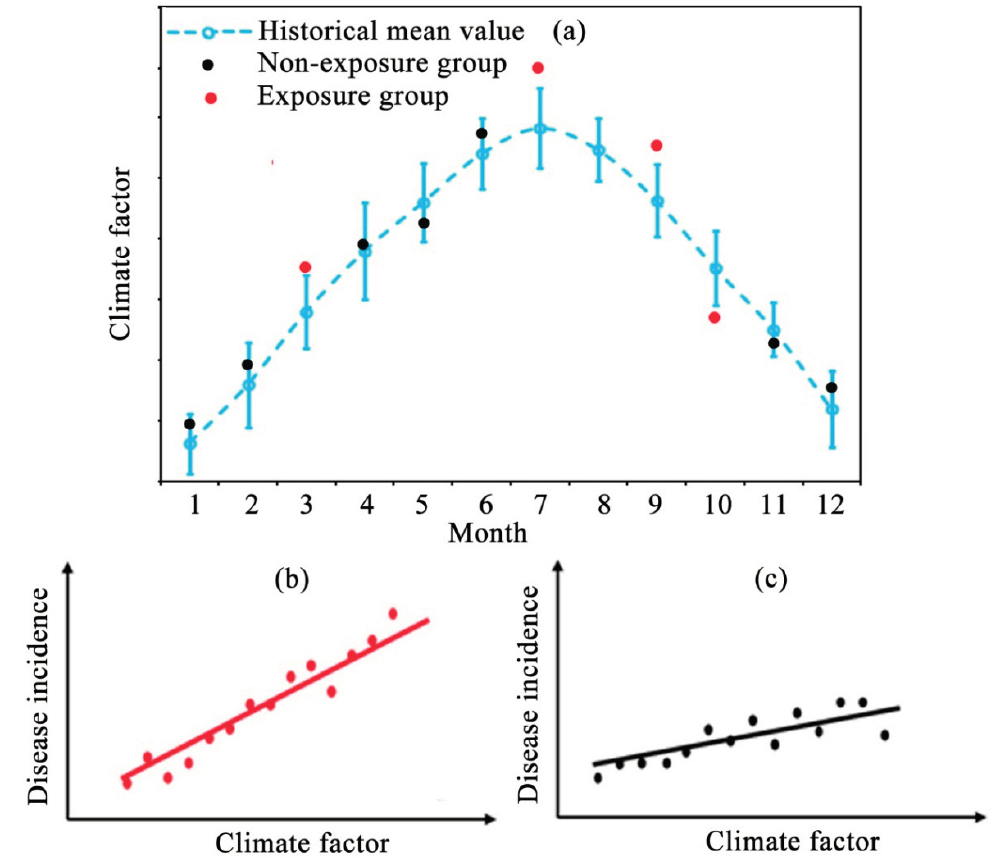
Figure 2. Schematic figure for calculating the Relative Sensitivity: ( a ) identification of the exposure and non-exposure groups; ( b ) linear model of the exposure group; ( c ) linear model of the non-exposure